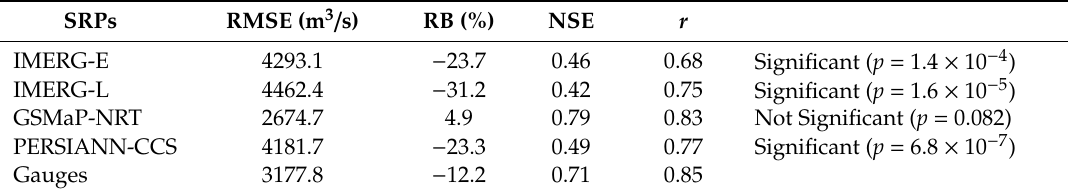
Table 2. Statistical performance of satellite rainfall products in simulating river